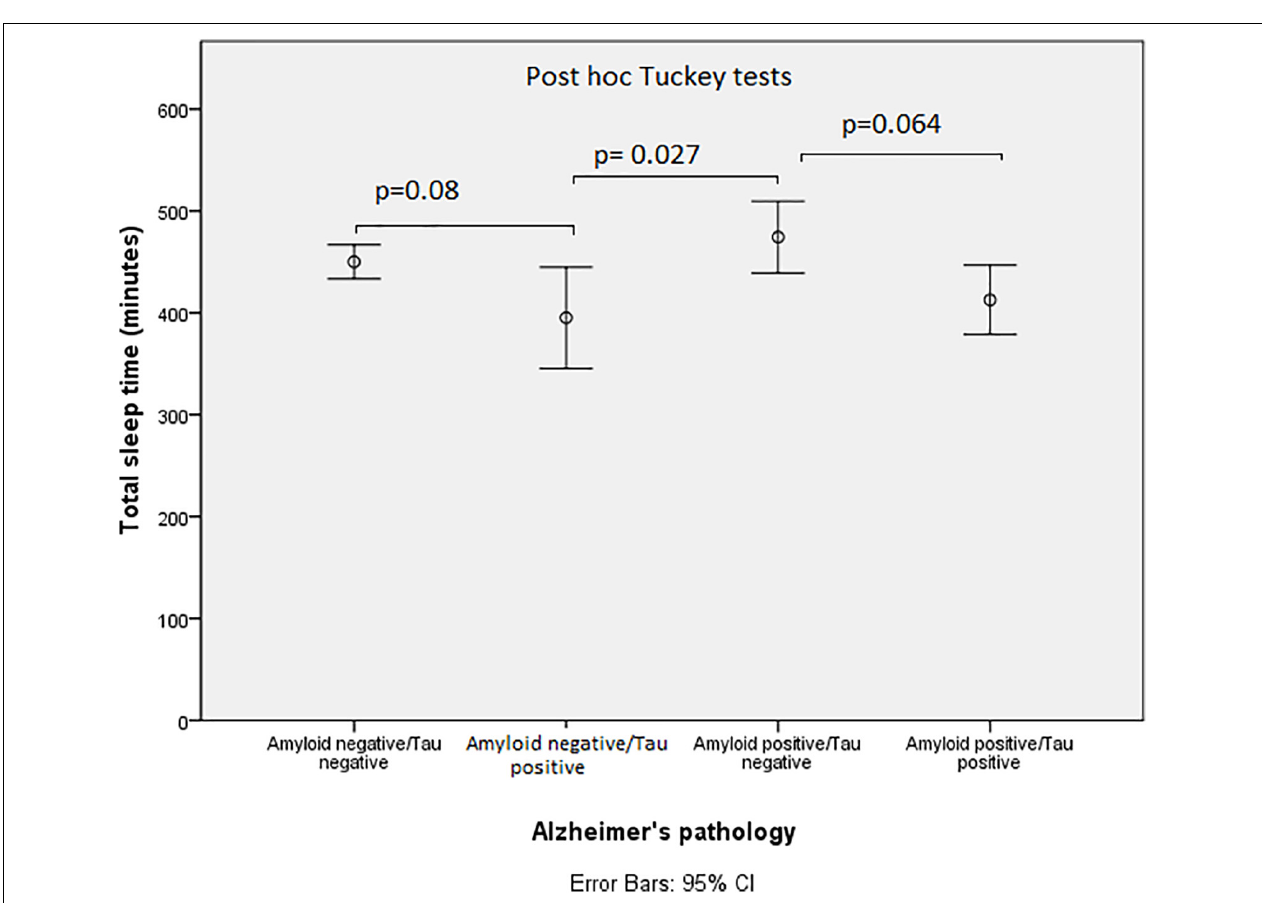
FIGURE 2 | Distribution of total sleep time across the “ATN” NIA-AA classification. Error bars displaying total sleep time across the ATN groups show that individuals with positive tau biomarkers tended to have less sleep time.